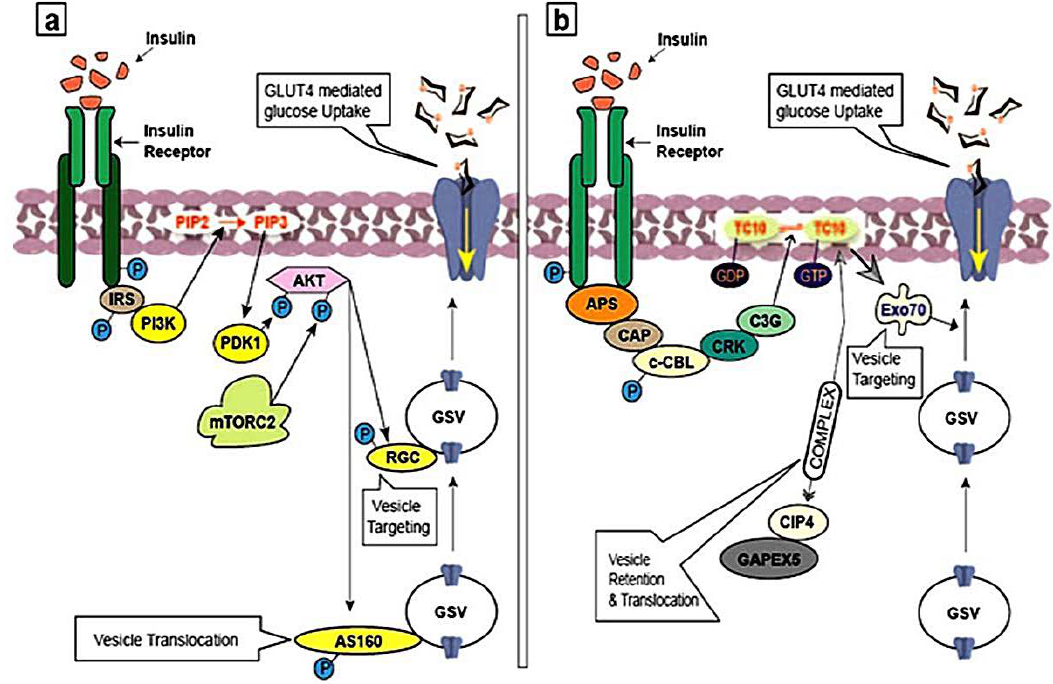
Figure 4. Insulin signaling cascades regulate GLUT4 trafficking by intracellular itinerary. ( a ) PI3K- mediated insulin signaling pathway: Being active by insulin binding, this pathway leads to the involvement and phosphorylation of IRS adaptor proteins. Tyrosine phosphorylated IRS